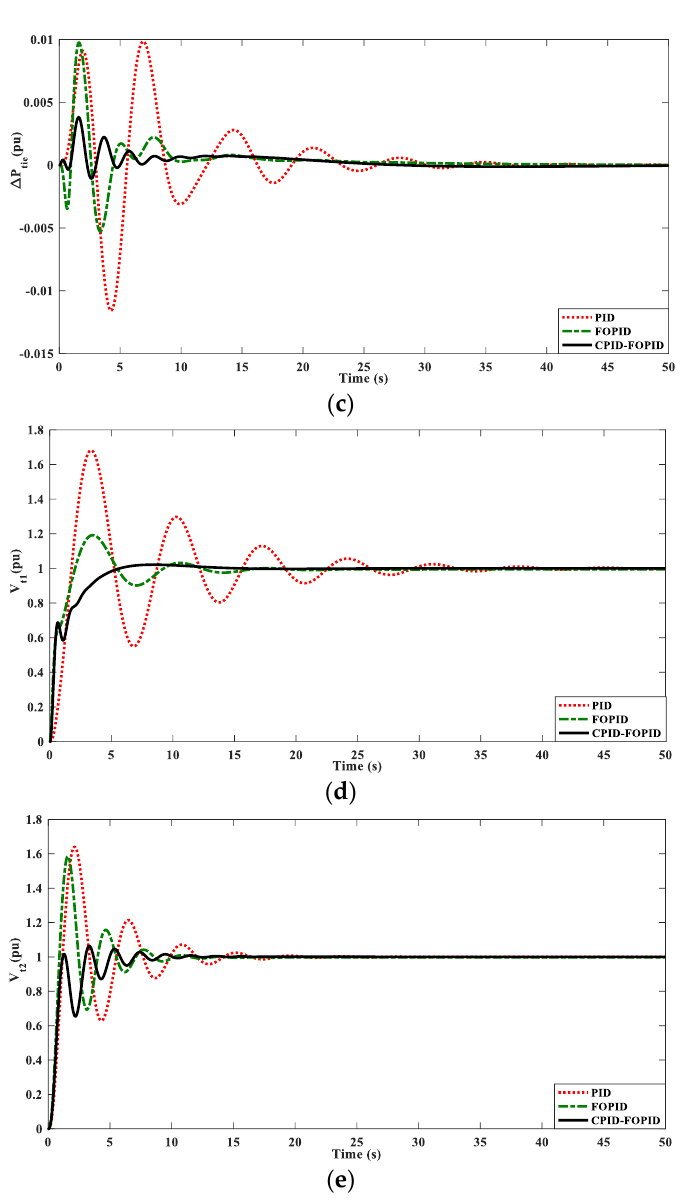
∆ f ∆ P 1 ; ( b ) 2 ; ( c ) tie ; ( d ) V t 1 ; ( e ) V t 2 .